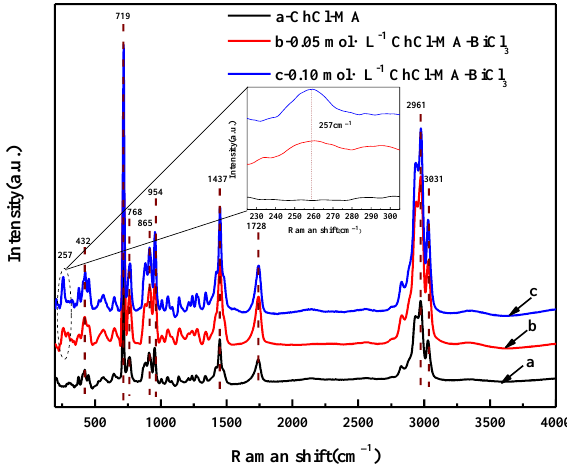
Figure 3. Raman spectra of ChCl-MA system and ChCl-MA-BiCl 3 . By comparing with the Raman spectrum of the ChCl-MA system, after adding BiCl 3 , a new band can be observed at 257 cm − 1 , as shown in the inset of Figure 3. Vieira et al.